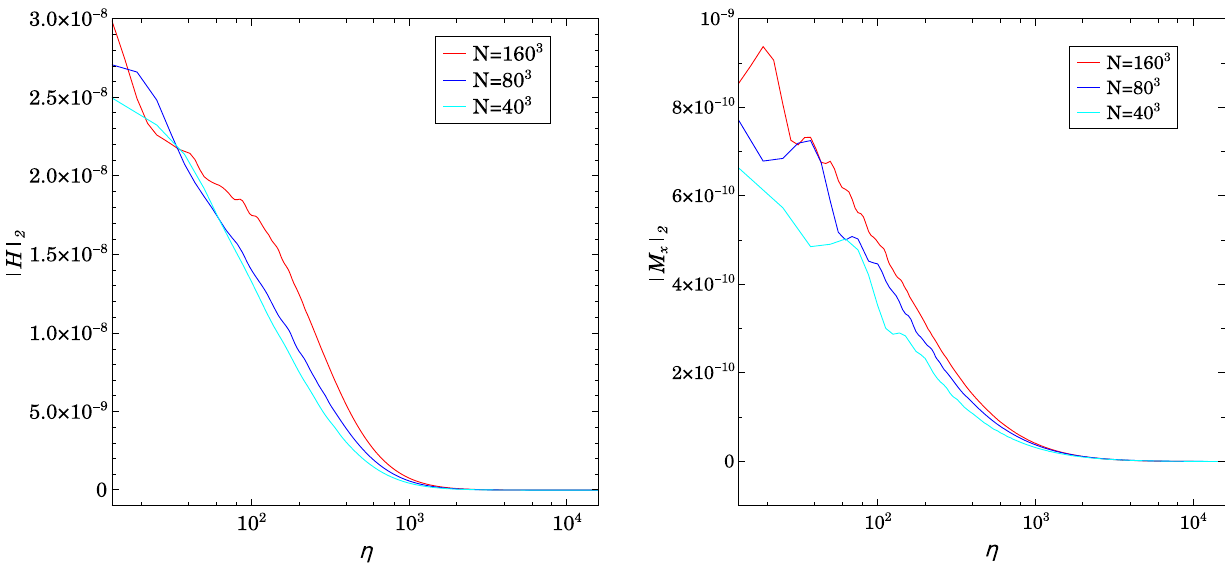
Fig. 5 L 2 norms of the Hamiltonian constraint violation and the x-component of momentum constraint violation at 160 3 (red), 80 3 (blue) and 40 3 (cyan)